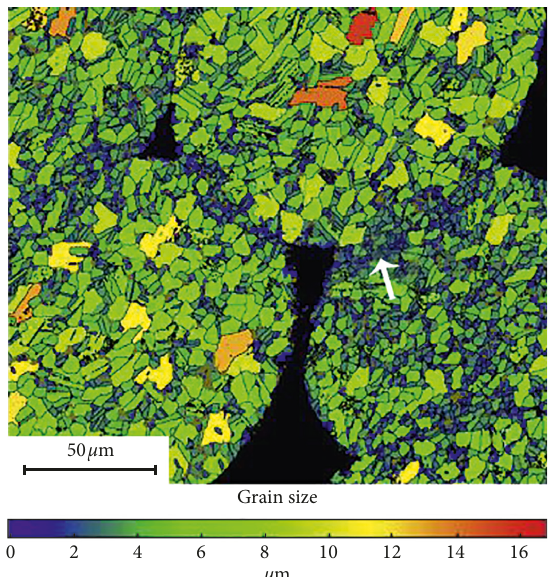
Figure 11: Size of the c -grains mapped by EBSD between powder particles (densification at 1421K). Grains are coloured in the function of their size (see colour scale) defined as the diameter of the circle of the same area. Small grains (in blue) are concentrated in the neck regions. The α gains are coloured in olive green. The 2 arrow indicates a concave interface for the particle at the middle right, indicating a strong plastic deformation of this particle, as adopted from